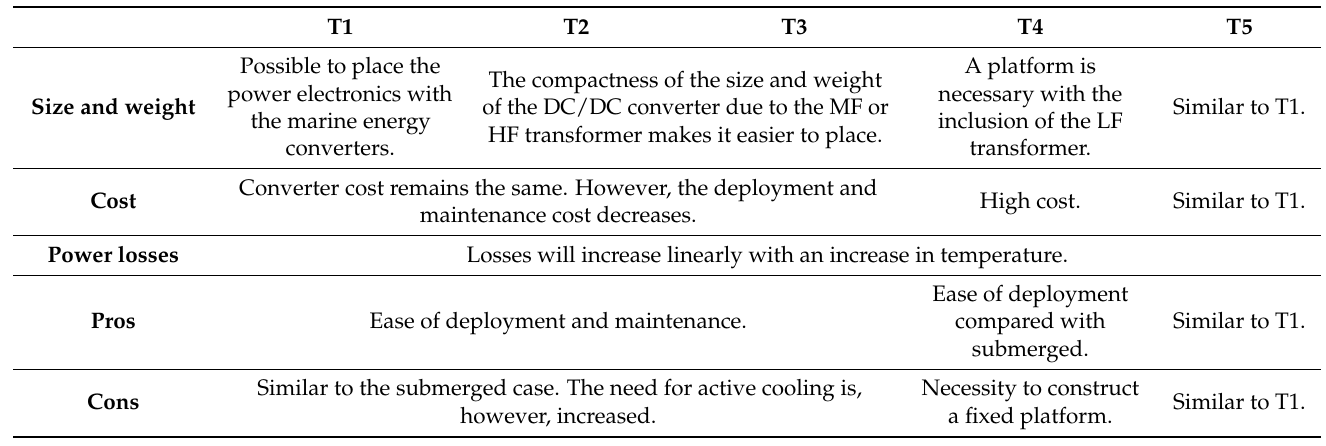
Table 2. Important characteristics of Topologies T1–T5 with a non-submerged marine energy